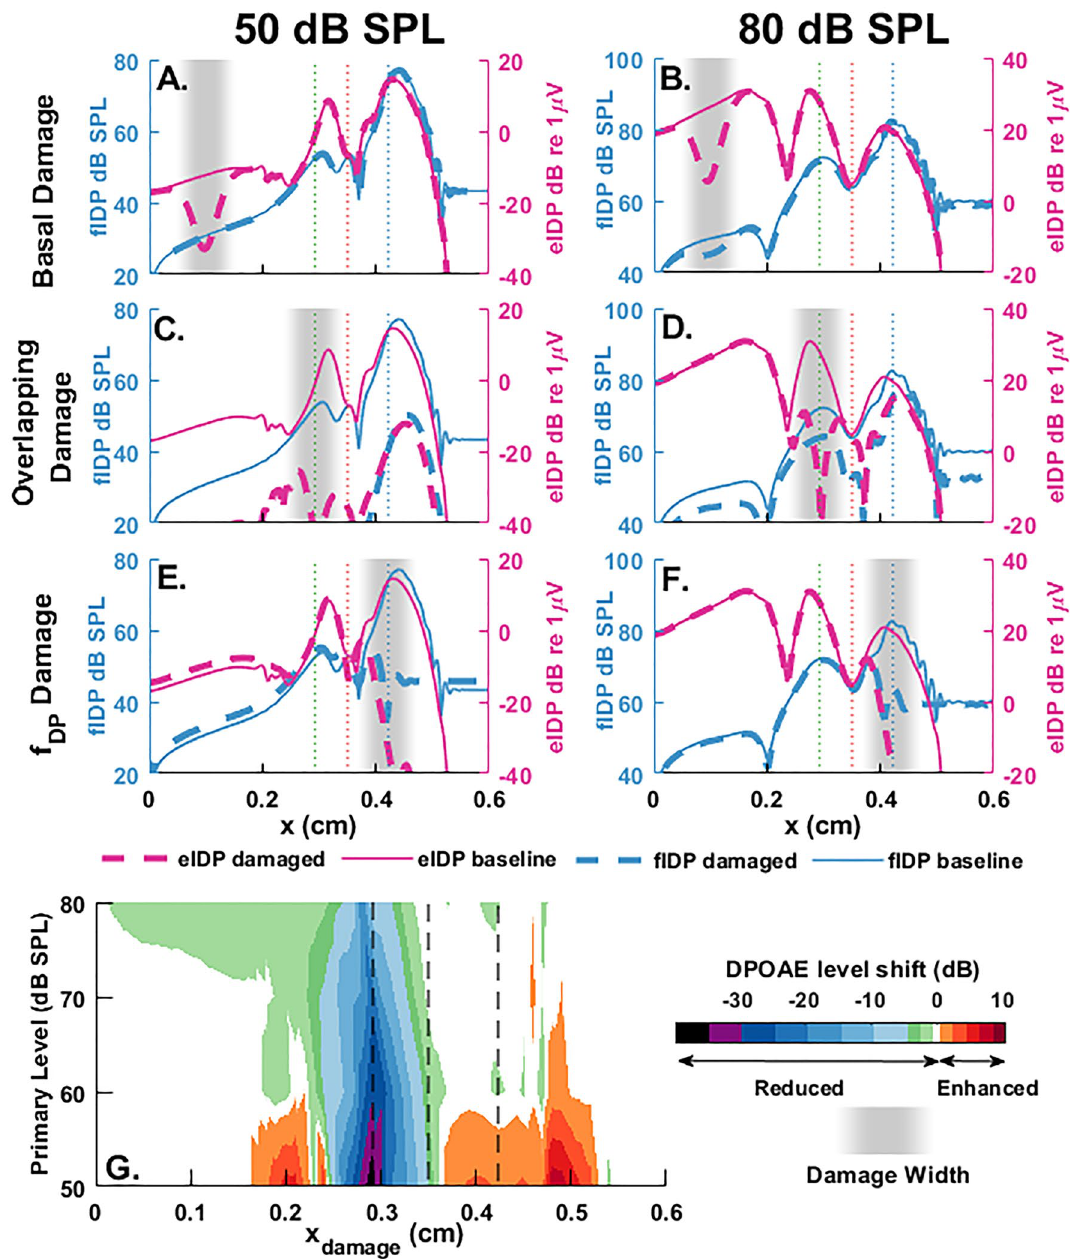
Figure 5. Effect of local OHC damage on the generation of IDPs and DPOAEs. ( A–F ) show the spatial responses of the eIDP (magenta lines) and fIDP (blue lines) for 50 dB SPL primaries (left panels) and 80 dB SPL primaries (right panels). The solid lines correspond to the baseline case; the dashed lines to the response when local damage is applied. The region of the damage shown in gray shaded area, includes approximately 20 sections of OHCs, and varies from a basal location ( A,B ), the overlap region ( C,D ) and the IDP tonotopic place ( E,F ). ( G ) Change of the DPOAE from its baseline value when the damage location is swept from the base to the apex for equal-level primaries of sound pressure levels between 50 and 80 dB. For all panels, f 2 = 20 kHz. In all panels, the vertical dashed lines correspond to the f 2 , f 1 and f DP tonotopic primaries, the basal OHC damage causes local reductions of about 20 dB in eIDP and 5 dB in fIDP (Fig. 5B). The basal nonlinear distortion component, which, as demonstrated earlier, is the main source of basal eIDPs in response to high primary levels (Fig. 4), appears to have a small effect on basal fIDPs and DPOAEs (Fig. 5G). Applying local damage in the primary overlap region has level-dependent effects on the IDP response (pan- els C,D). For 50 dB SPL primaries (Fig. 5C), the damage reduces eIDP and fIDP throughout the cochlea by a significant amount (> 30 dB) and the DPOAE by up to 38 dB SPL (Fig. 5G). These results strongly suggest that the DPOAE is primarily generated within the primary overlap region. At the higher primary level of 80 dB SPL